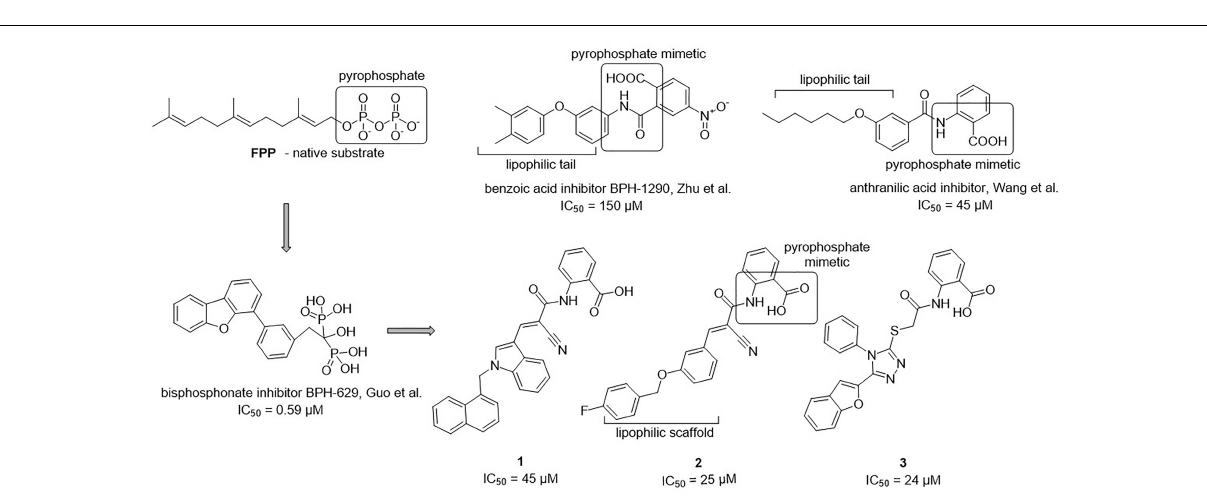
FIGURE 6 | Structural comparison of UppS native substrate farnesyl pyrophosphate (FPP), benzoic acid inhibitor (Zhu et al., 2013), anthranilic acid inhibitor (Wang et al., 2016), bisphosphonate inhibitor (Guo et al., 2007) and new inhibitors of E. coli UppS discovered by structure-based virtual screening.